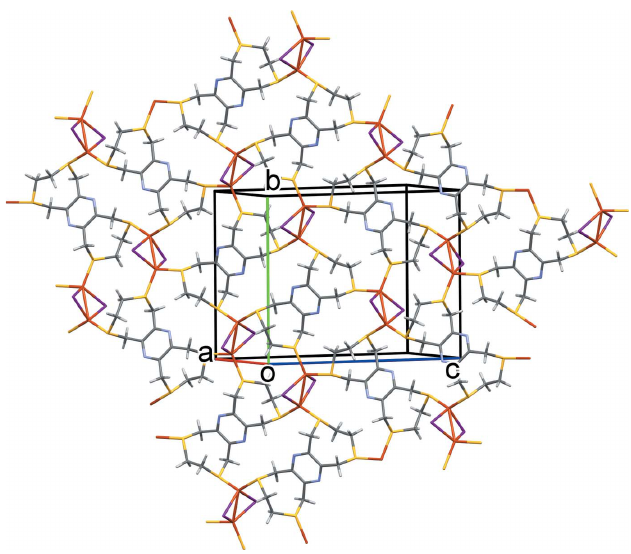
Figure 2 Aview, almost normal to plane (102), of the crystal packing of complex I .